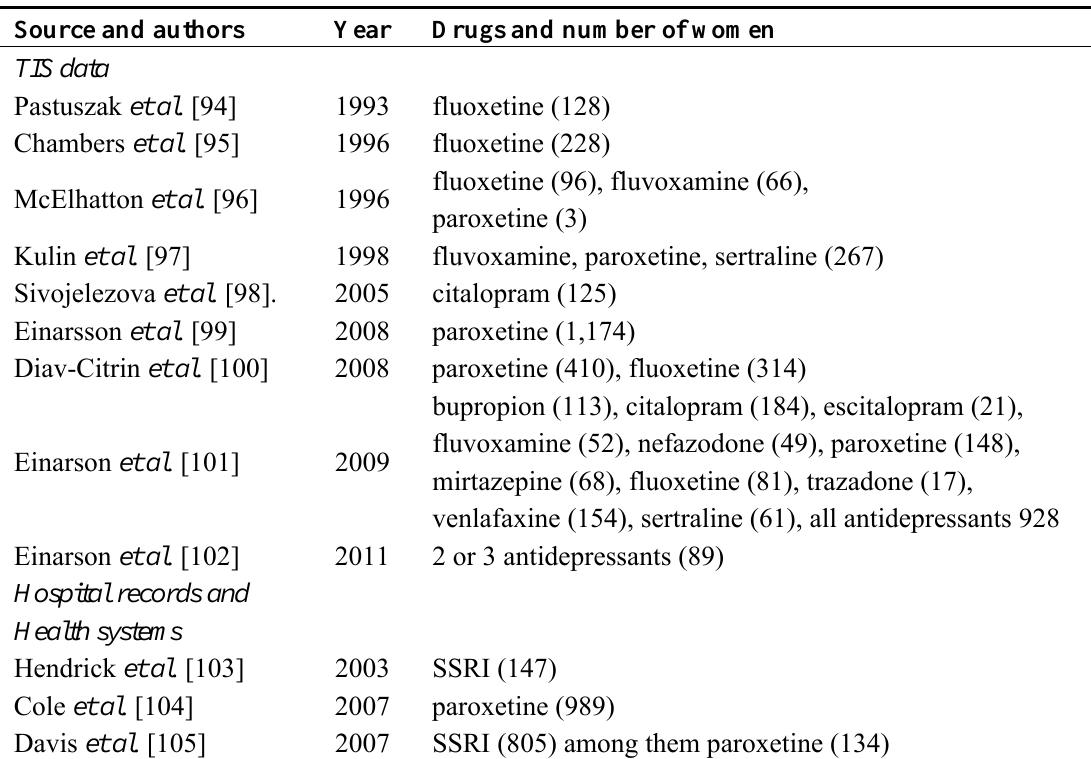
Table 28. Summary of literature on the association between antidepressant use and infant congenital malformations. Numbers of exposed infants within